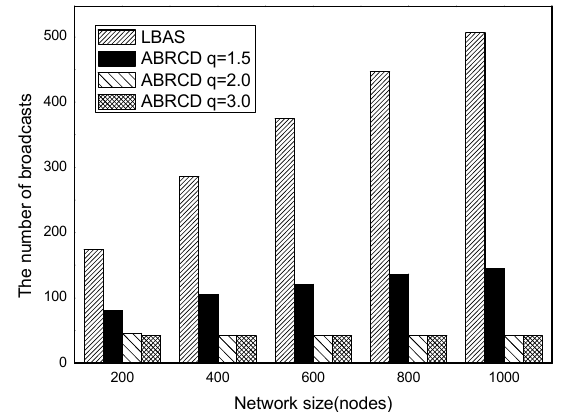
Figure 32. The impact of network size with fixed | T | = 20 on the number of broadcasts. Sensors 2018 , 18 , x FOR PEER REVIEW